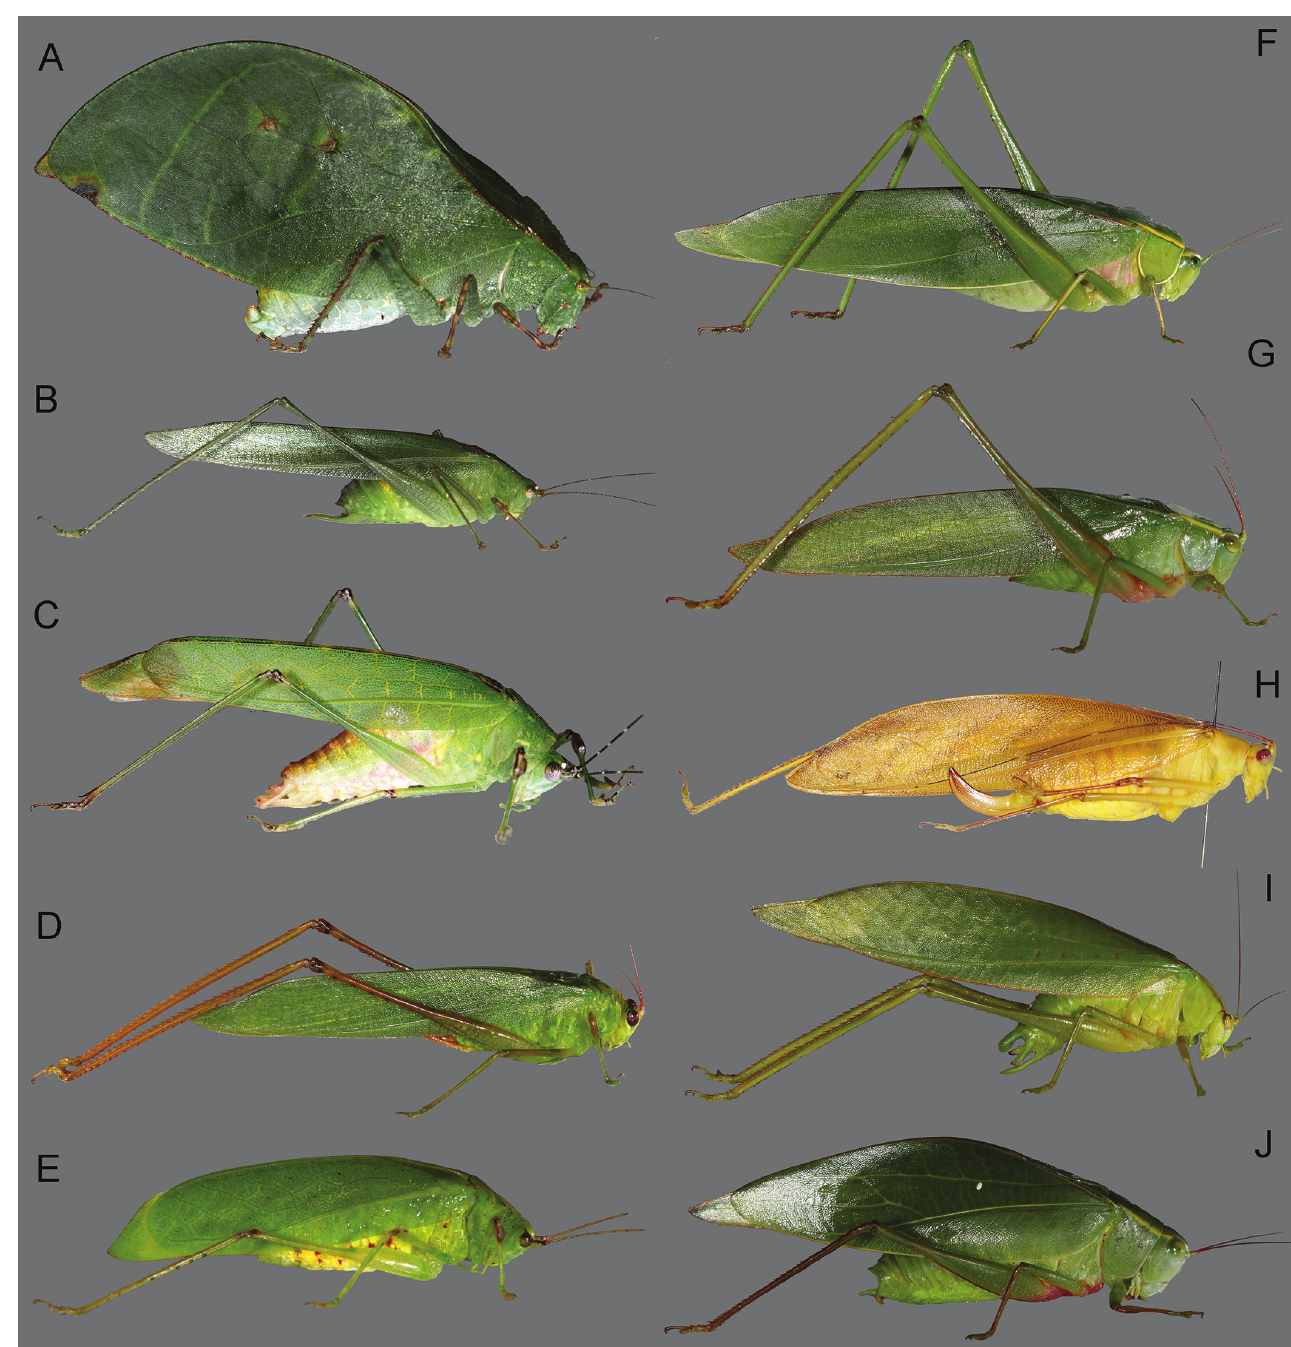
Fig. 16. Tettigoniidae: Phaneropterinae: A. Baryprostha bellua ; B. Casigneta bisinuata ; C. Hemimirollia gracilis ; D. Holochlora sp.; E . Mirollia cf. abnormis ; F. Liotrachela (?) sp.; G. Liotrachela hyalina ; H. Phygela cf. marginata ; I. Rectimarginalis nr. profunda ; J. Sympaestria lampra .